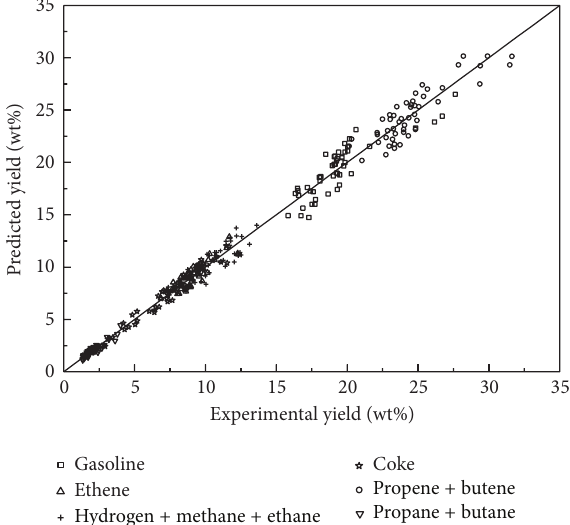
Figure 3: Comparison of the experimental yields (points) and the model-predicted yields (line) in HAGO catalytic pyrolysis at 640 ∘ C.